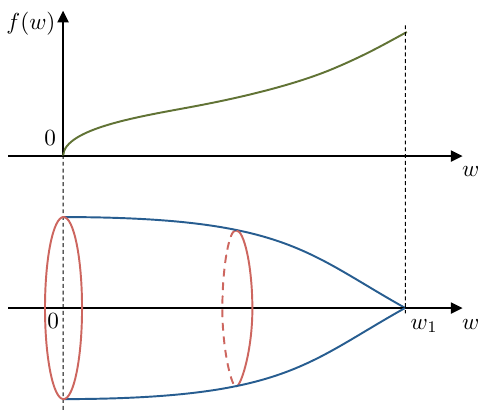
Figure 1. A schematic depiction of the internal geometry for the choice of parameters and range of the w coordinate specified in (2.5). The z circle is fibered over the w interval to yield Σ with metric ds 2 (Σ) in (2.1). Σ has the topology of a disk with a Z